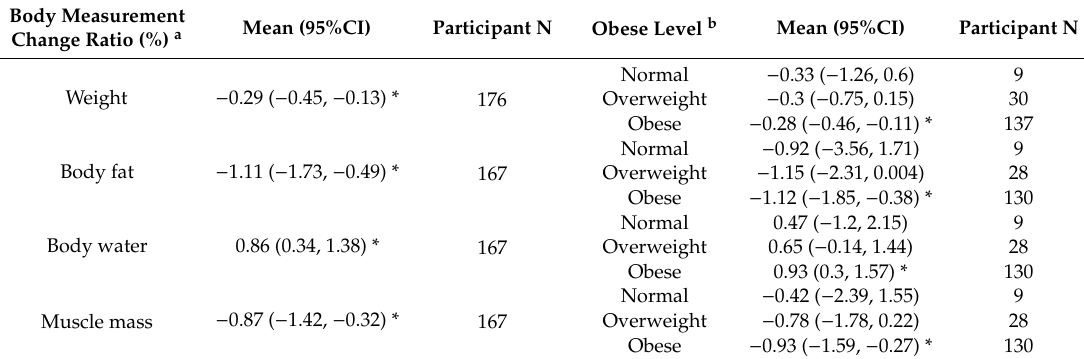
Table 5. Body measurement change ratios (%) of participants after the